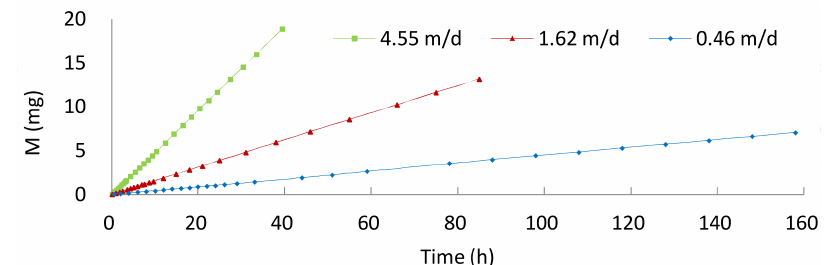
Figure 4. Total deposited mass in the